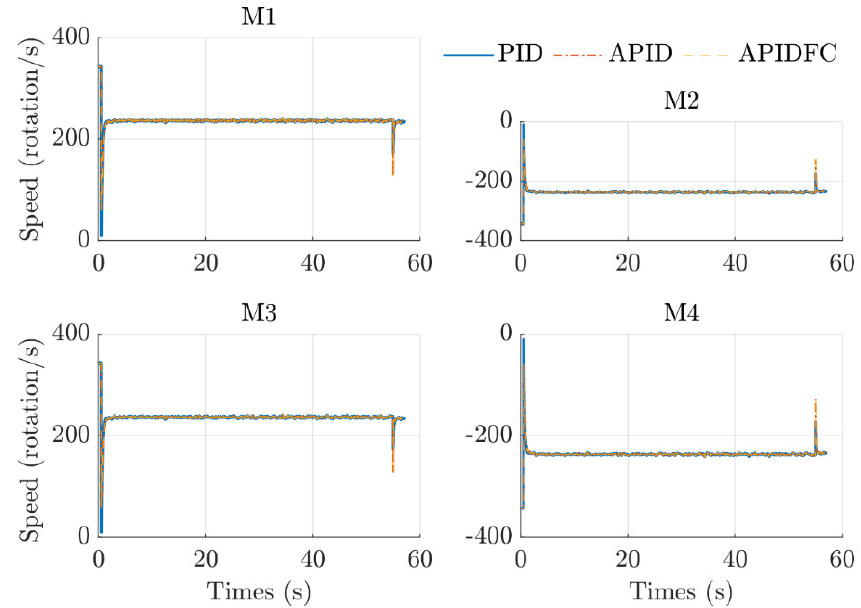
Figure 7. Motor rotation speed in the hovering simulation.